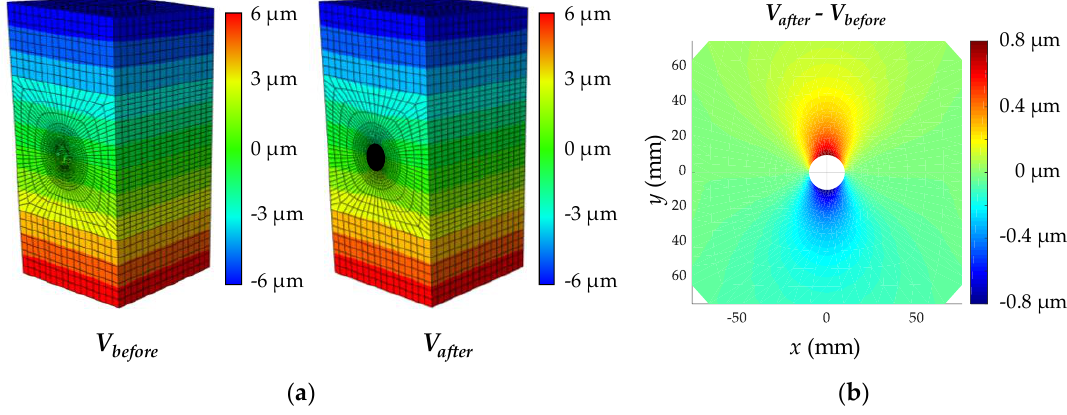
Figure 5. Displacement fields calculated using the FE model: ( a ) Displacement field of the intact and the damaged concrete, respectively denoted by V before and V after , obtained by the FE model; ( b ) The displacement field due to the hole-drilling.